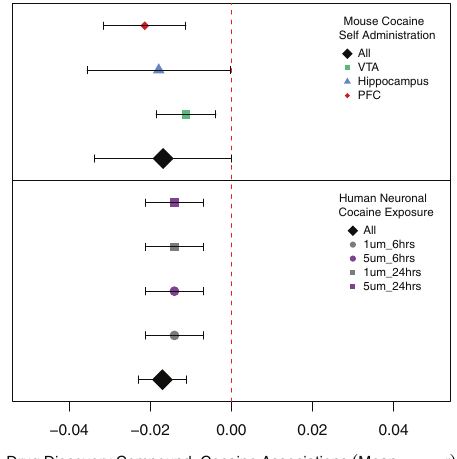
Fig. 3 Computational follow-up in preclinical models of cocaine use. The top panel shows associations between the neuronal signatures of ibrutinib and differential expression results from the in vitro cocaine neuronal exposure data. The bottom panel displays the associations between the neuronal signatures of ibrutinib with differential expressed genes from the mouse cocaine self- administration